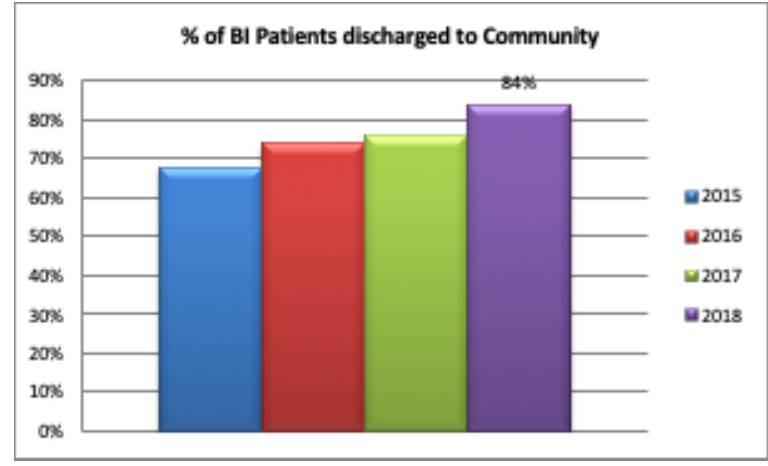
Figure 2. The percentage of patients discharged to the community in 2015 through